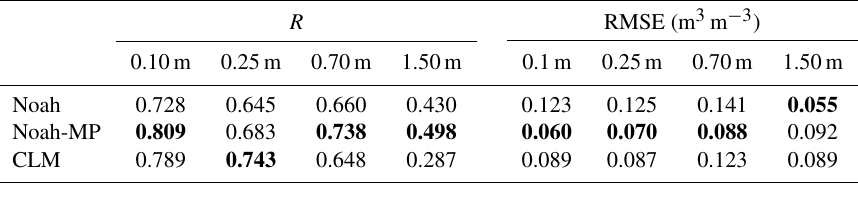
Table 3. Statistical summary of the WRF performance in simulating soil moisture for different soil layers, based on comparison with the single-point in situ observations. Note: the bold values show the best performance within each of the soil layers.